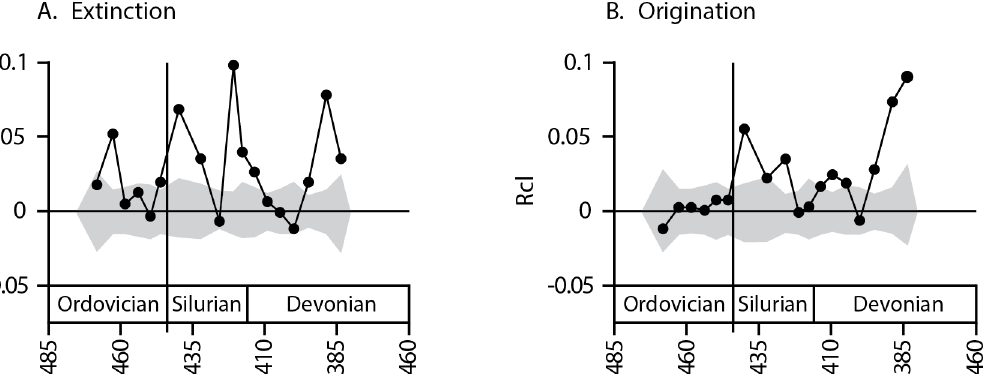
Fig 2. Taxonomic clustering of A. extinction and B. origination for brachiopod genera within substages for the Ordovician through the Devonian. Only intervals with over 100 genera are included in this analysis, as sample sizes smaller than this produce large variations in the null model. Because of this, several early Ordovician and Late Devonian intervals are not included. Results at this finer temporal subdivision largely confirm the results for both families and superfamilies at the stage level, with a shift from predominantly random to predominantly clustered (8 of 12 intervals for extinctions, 9 of 12 for originations) turnover following the Late Ordovician mass